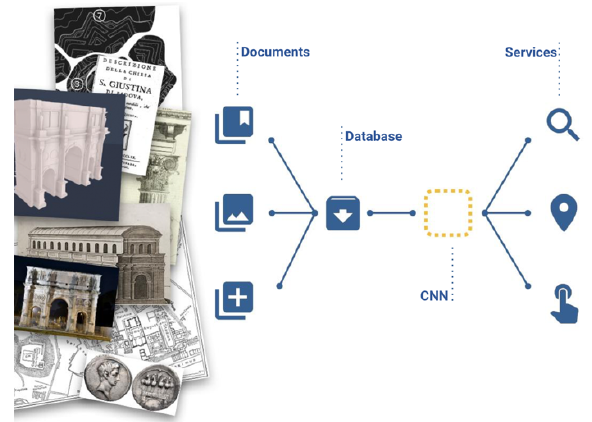
Figure 5. Schema of the connection between the Cult database and the functions available through the